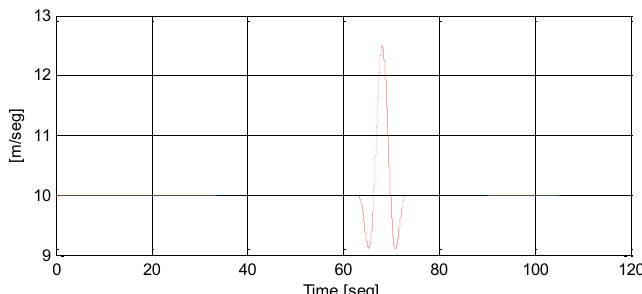
Figure 2. Extreme Operation